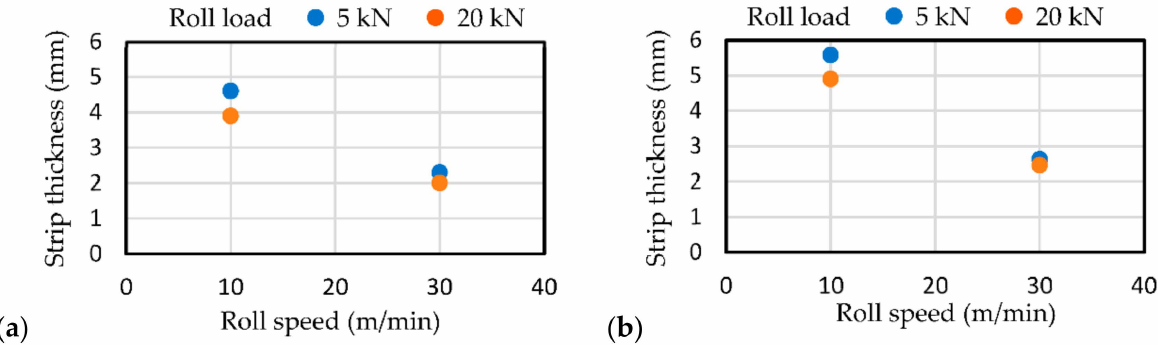
Figure 4. Effects of roll materials on strip thickness. The rolling speed was 10 or 30 m/min, and the roll load was 5 or 20 kN. ( a ) Mild steel roll and ( b ) copper roll.